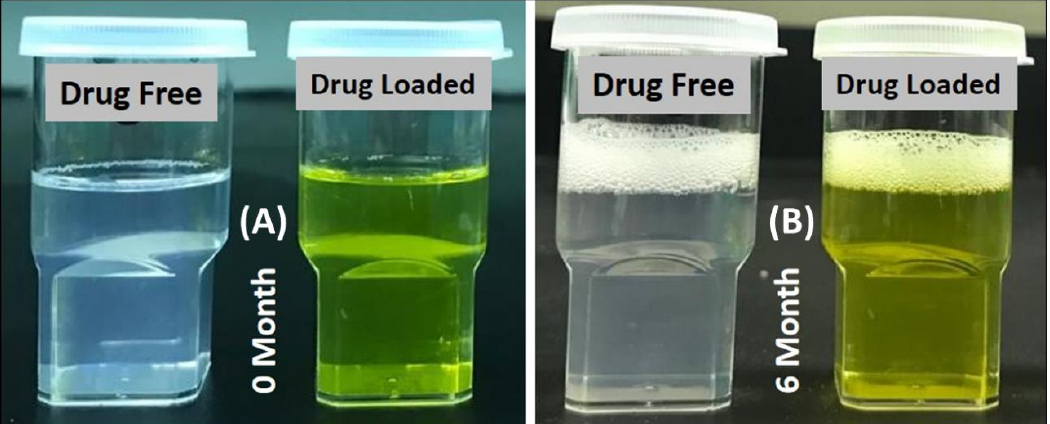
Figure 2. Morphology of the drug-free and drug-loaded SNEDDSs when 100 mg of blank formulation was diluted in 100 mL of water in ( A ) 0 months and ( B ) after 6 months of storage.